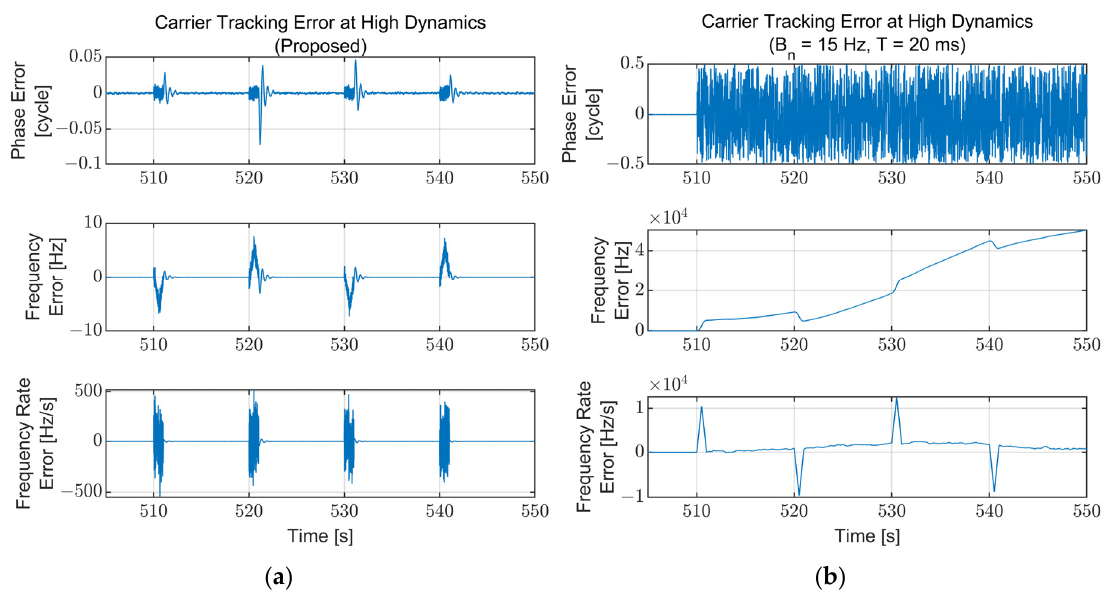
Figure 15. Carrier tracking error at the high dynamics region (500–550 s): ( a ) Proposed algorithm; ( b ) Fixed bandwidth (B n = 15 Hz, T = 20 ms). The fixed-bandwidth loop loses lock at approximately 510 s immediately after the jerk dynamic stress occurs. The error for the proposed algorithm in- creases temporally while the jerk dynamic stress exists and converges to zero immediately after disappearing.